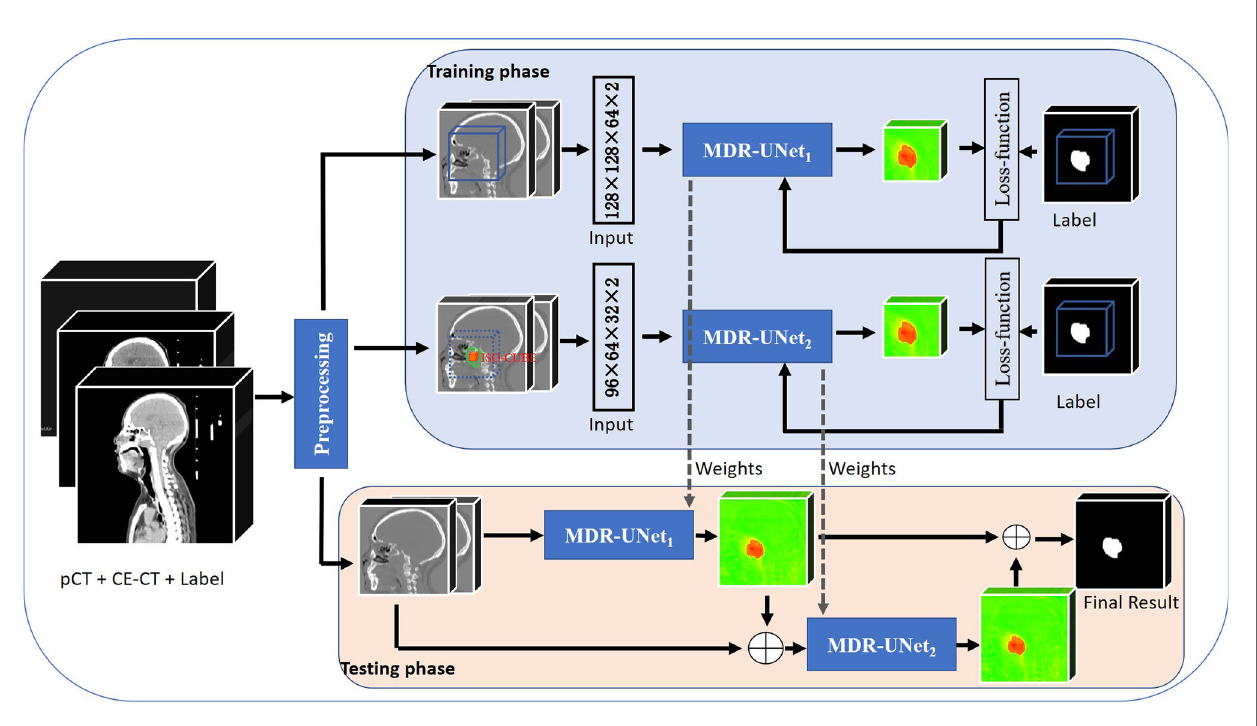
FIGURE 1 | Overview of the work fl ow of the proposed